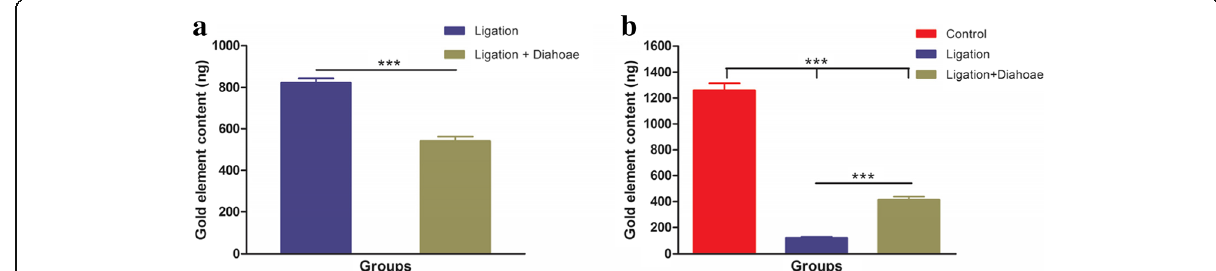
Fig. 8 Content of GNRs at the intestinal tissues 7 days after injection ( a ), and gold element content of feces ( b ) based on ICP-MS analysis. *** P < 0.01, showing a significant difference between ligation groups and ligation + diarrhea groups